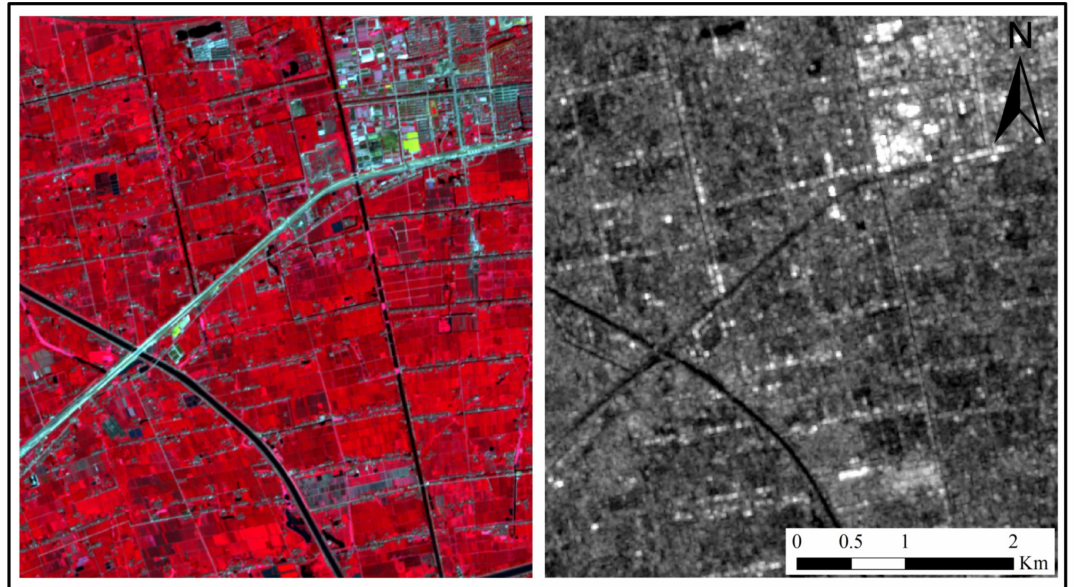
Figure 2. A demonstration of optical (Sentinel-2, Red: Band8, Green: Band4, Blue: Band3) and synthetic aperture radar (SAR) (Sentinel-1 VV)